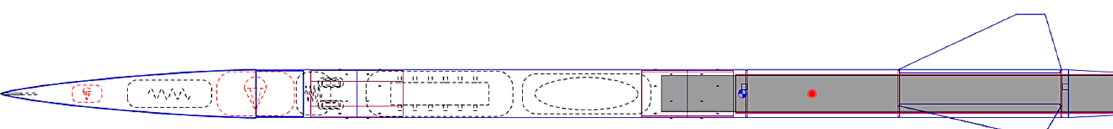
Figure 8. Ad Astra II rocket [48].